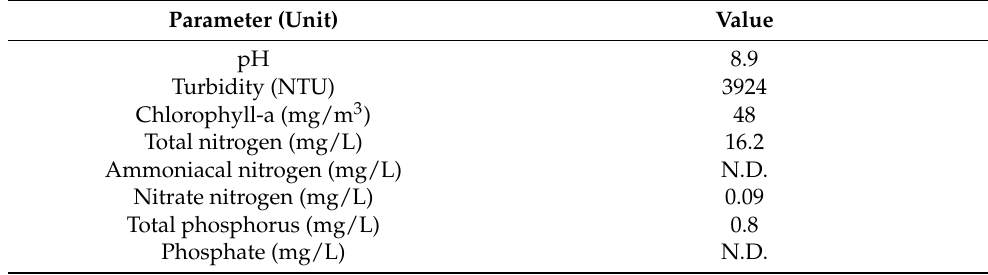
Table 1. Physical and chemical characteristics of the raw water in this study.